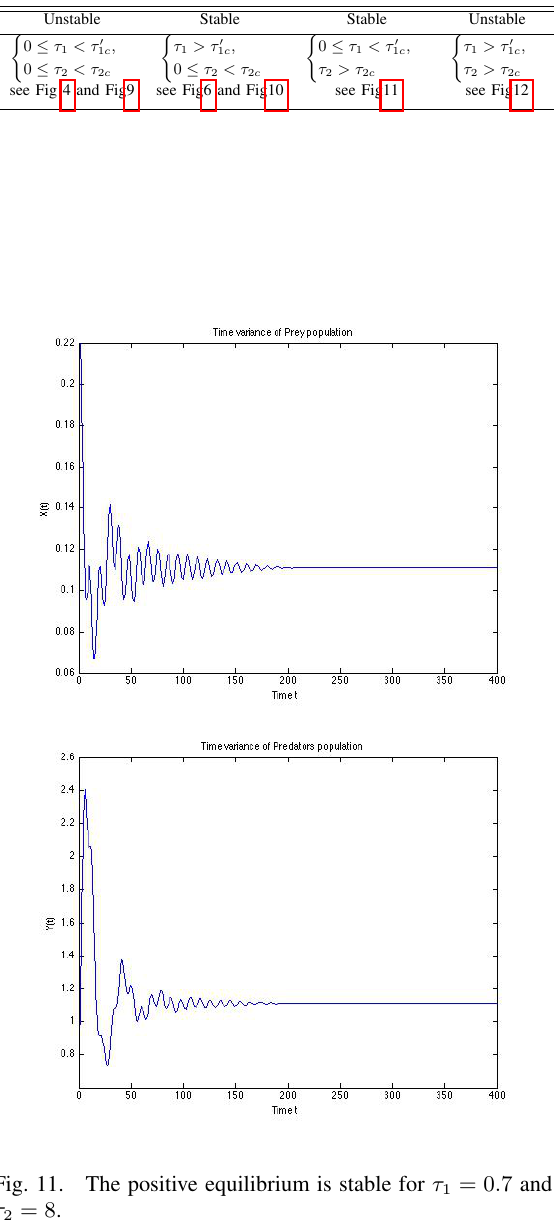
Fig. 11. The positive equilibrium is stable for τ 1 = 0 . 7 and τ 2 = 8